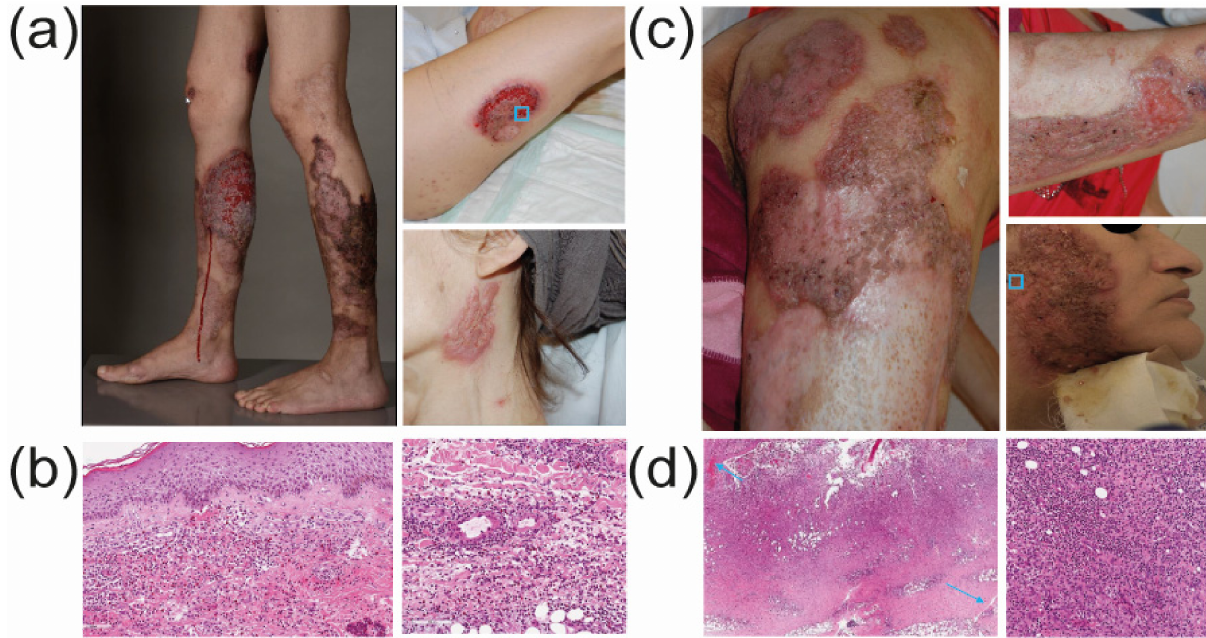
Figure 1. Skin changes and histology of CLAAS over time. ( a ) Clinical presentation upon first admission. The patient had extensive polycyclic ulcerations on lower legs and forearms, partly covered by yellowish exsudate and with an undermined edge and surrounding erythematous– violaceous border. There was also cribriform scarring, as shown on the neck. ( b ) Hematoxylin and eosin (H&E) staining (indicated scale, 100 µ m) of a lesional skin biopsy taken from a lesion border (as indicated in ( a )) shows a leukocytoclastic hemorrhagic vasculitis. There is a massive, subepidermal neutrophilic infiltrate with some rare eosinophils, as well as extensive hemorrhage. ( c ) Clinical presentation after four years. Disseminated cribriform ulcerations and extensive scars on the upper leg (left), forearm and face. ( d ) H&E staining of a lesional skin biopsy taken from an ulcer (as indicated in ( c )) shows prominent, focally granulomatous neutrophilc infilitrates and fistula in the dermis/hypodermis, which are indicative of